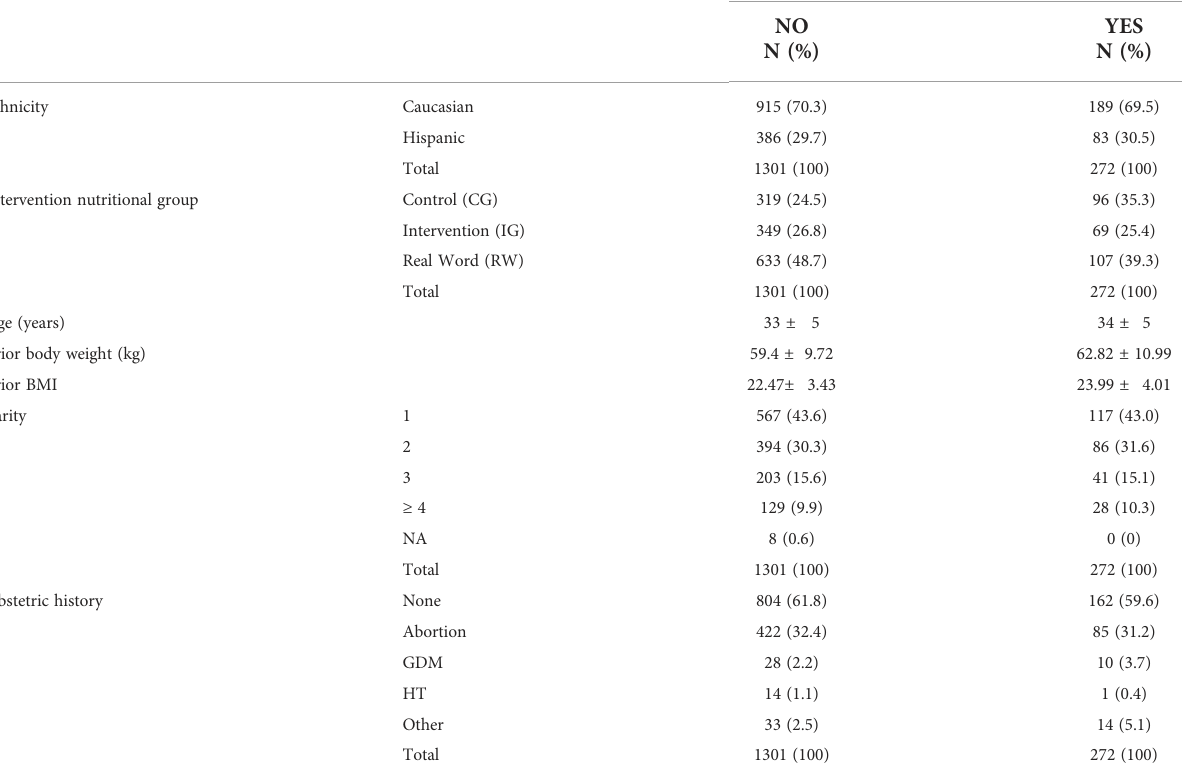
TABLE 1 Main characteristics of patients included in the